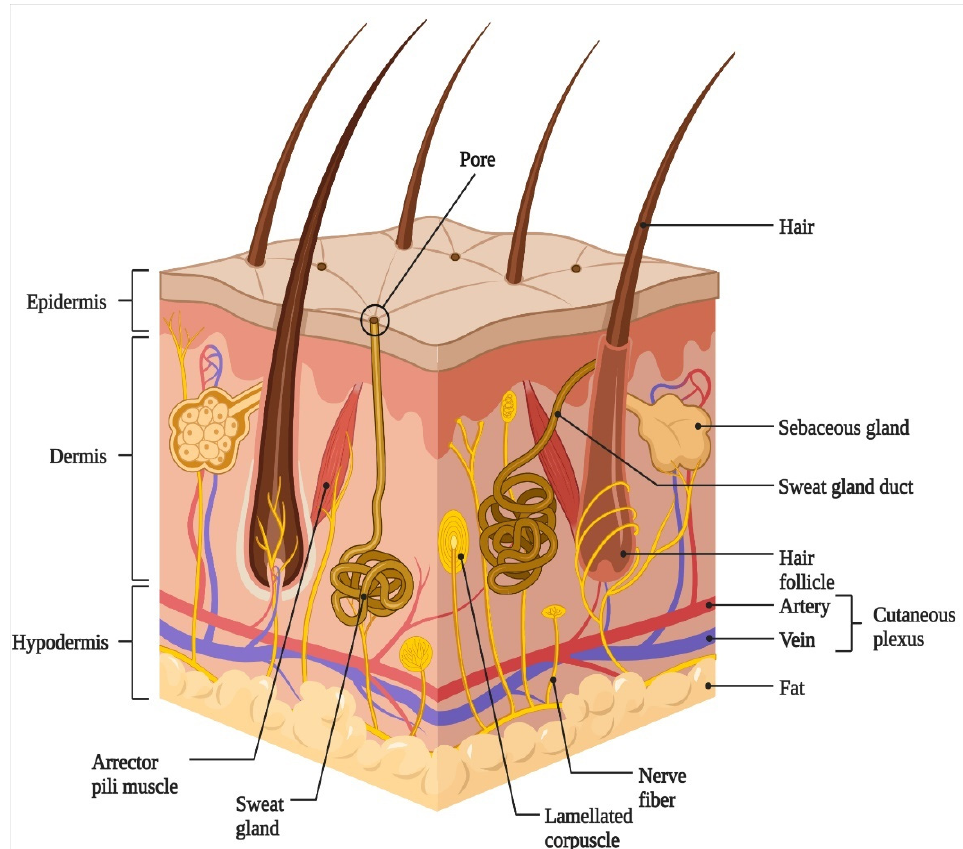
Figure 1. Schematic representation of basic human skin anatomy depicting the different skin layers and their components.